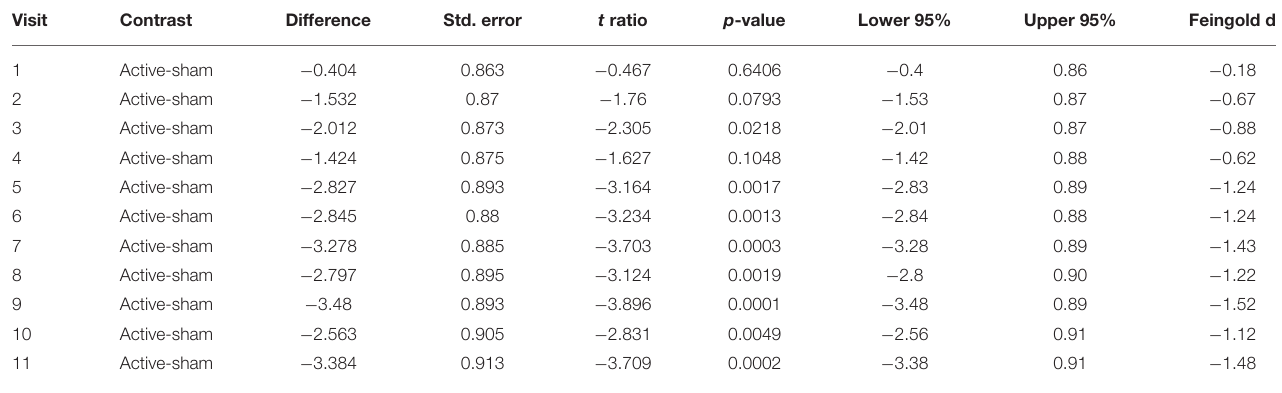
TABLE 2 | Least square mean differences between participants receiving active vs. sham treatment across visits by mixed model.